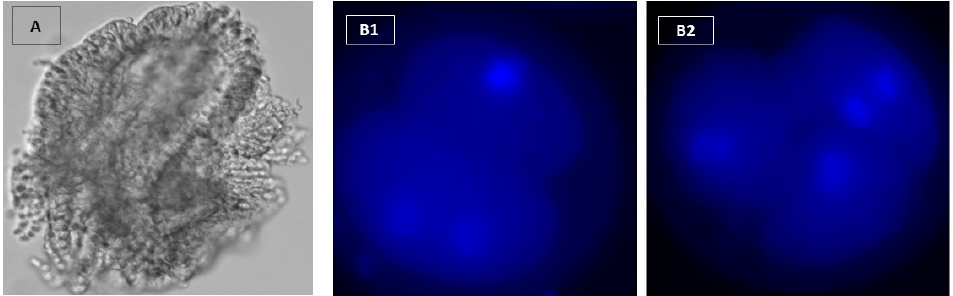
Figure 2. ( A ): Cell aggregates from oviduct with a circumference of 100–150 μ m. Embryos were stained with Hoechst 33342. ( B1 , B2 ) show three cell-4 cell stages, respectively